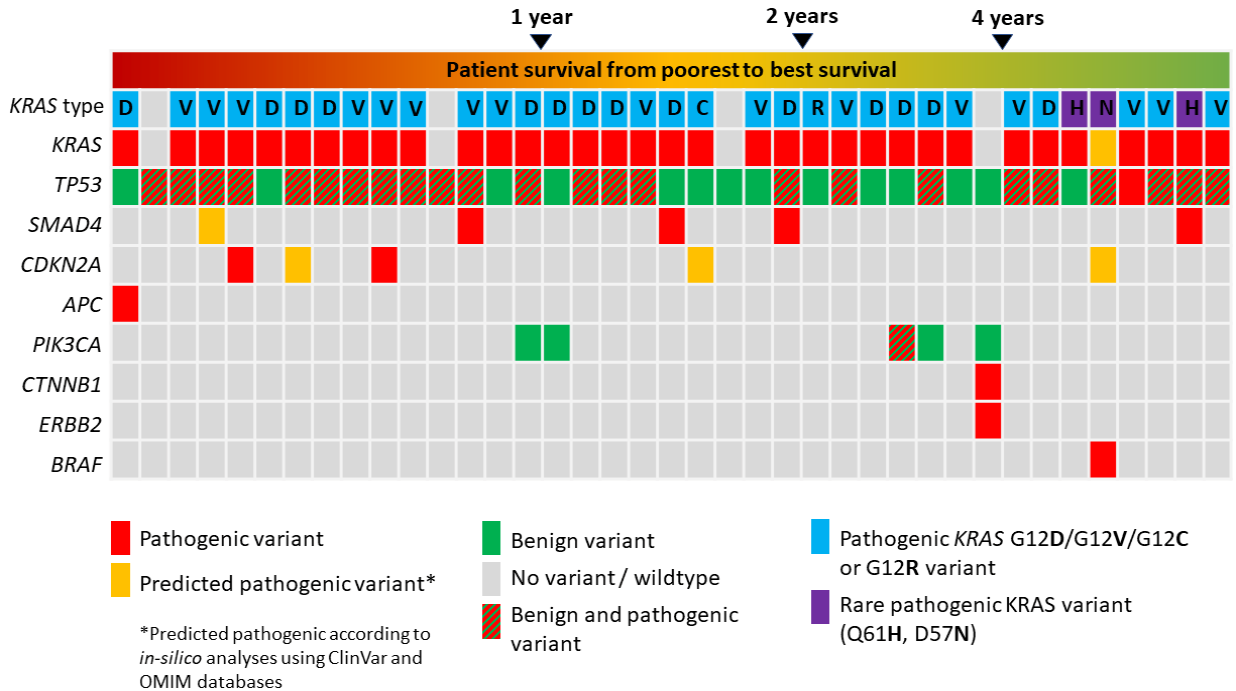
Figure 2. Oncoprint with an overview of all cases in this study whose next generation panel sequencing (NGS) was successfully performed. Rare pathogenic mutations of KRAS were only noted in long-term survivors.